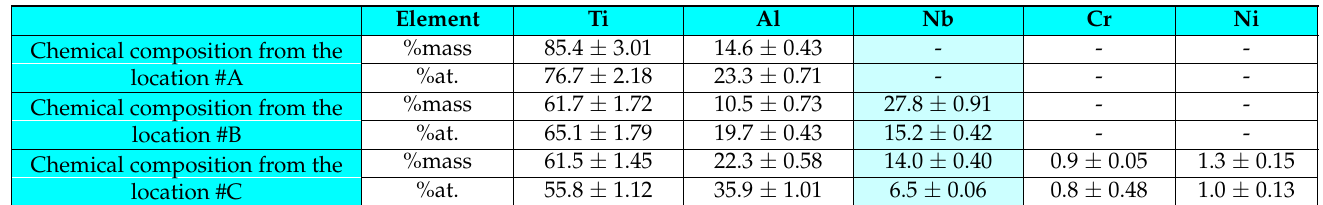
Table 2. EDS analysis results in points marked in Figure 12 (mean values and standard deviations).